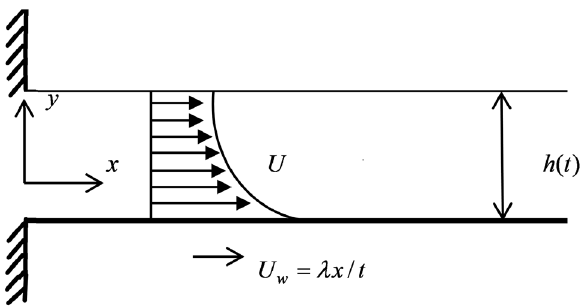
Figure 1. Schematic representation of the